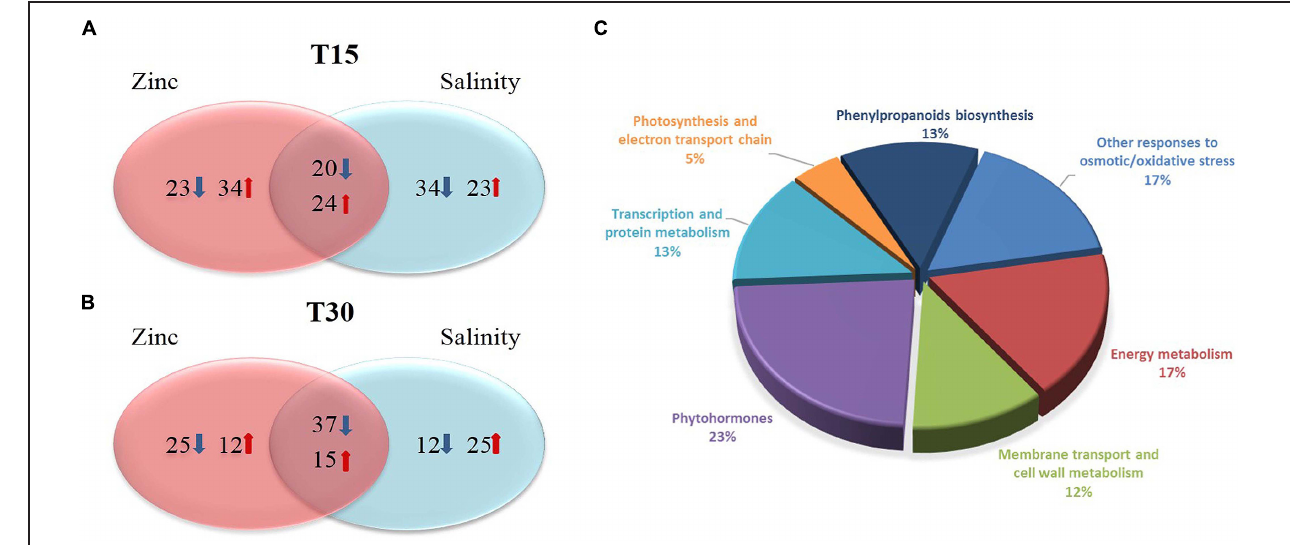
FIGURE 2 | Venn diagrams of the proteins resulting up- or down-accumulated after 15 and 30 days (A, upper and B, lower pane for earlier and later time point, respectively), together with the classification